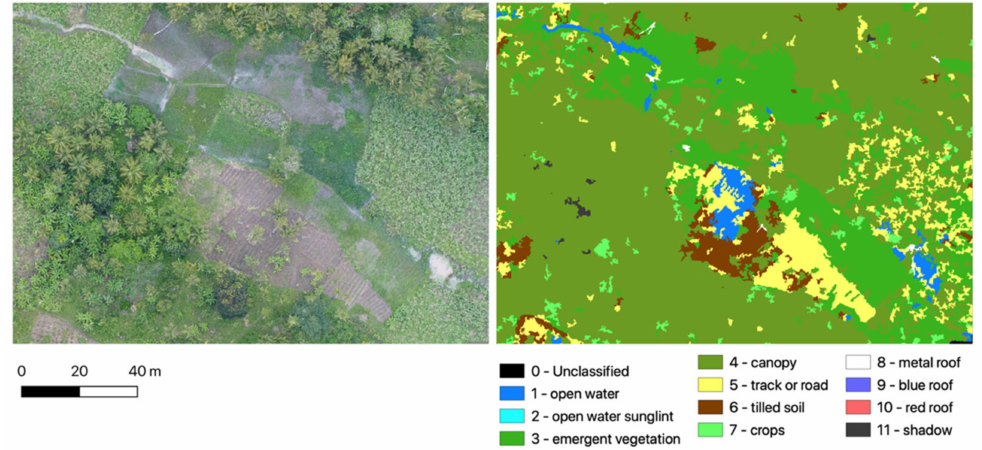
Figure 6. Example classification of drone imagery from May 2021 over Ndagaa. Example demon- strates misclassification of bare soil as open water and crops as inundated vegetation. A total of 1660 points were interrogated as part of the accuracy assessment of the TAD sites. The overall accuracy scores for the TAD approach using RegionGrow was consistently high, with a mean of 95.7% and a range from 89.3% to 99% (Table 5). The F1 scores, measuring both recall and precision also demonstrated a high level of accuracy (mean 0.95, range 0.88 to 0.99). Errors occurred where neighbouring pixels had similar spectral characteristics but belonged to different land cover types. For instance, extensive open water in tilled rice paddy: here open water with heavy sediment load is spectrally very similar to surrounding bare soil/mud (for example, see Figure 7)—although, these instances could be alleviated by adapting the Euclidean distance thresholds within RegionGrow. Additionally, overhanging vegetation canopies obscured the water surface below and were not visible in the drone imagery. In most instances, this occurred along stream channels with riparian vegetation overhanging the channel making the water body feature appear fragmented (Figure 8). Table 5. Summary of accuracy assessment results and digitizing time for the TAD approach using RegionGrow, compared against the overall accuracy of the supervised classification